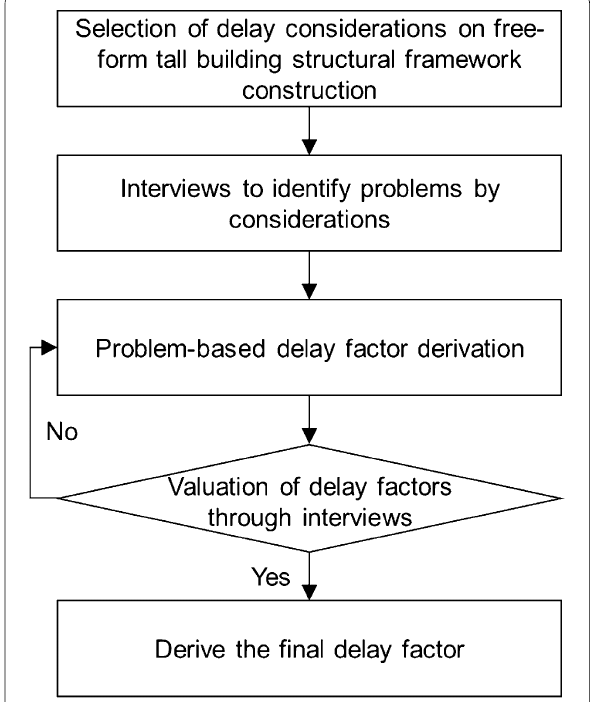
Fig. 1 Derivation process of the delay factor.